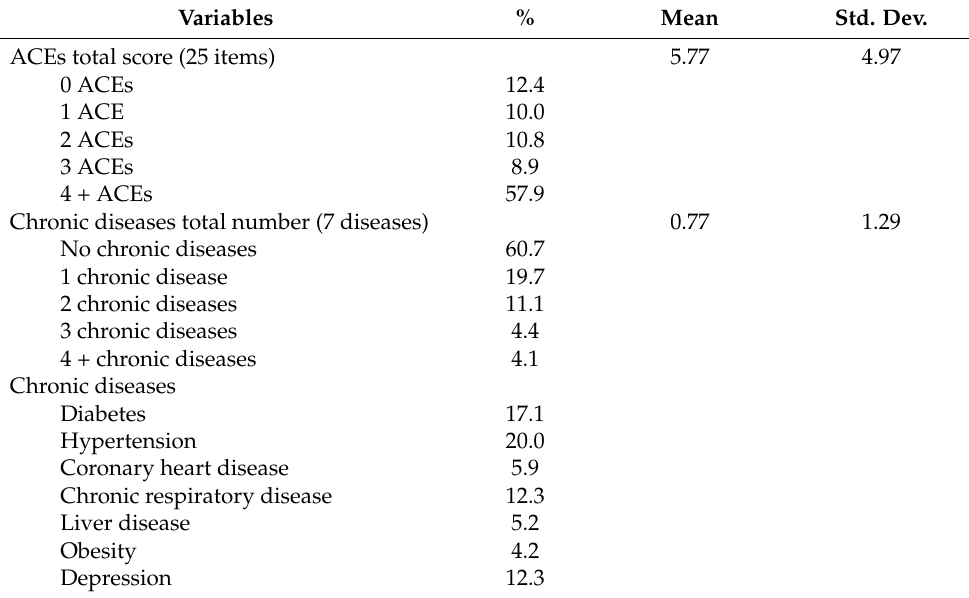
Table 2. Prevalence of ACEs and CD (N =